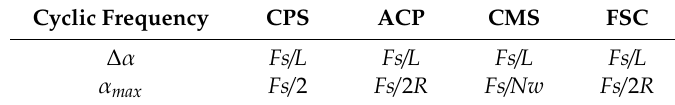
Table 1. Cyclic frequency parameters of four cyclic spectral analysis algorithms.